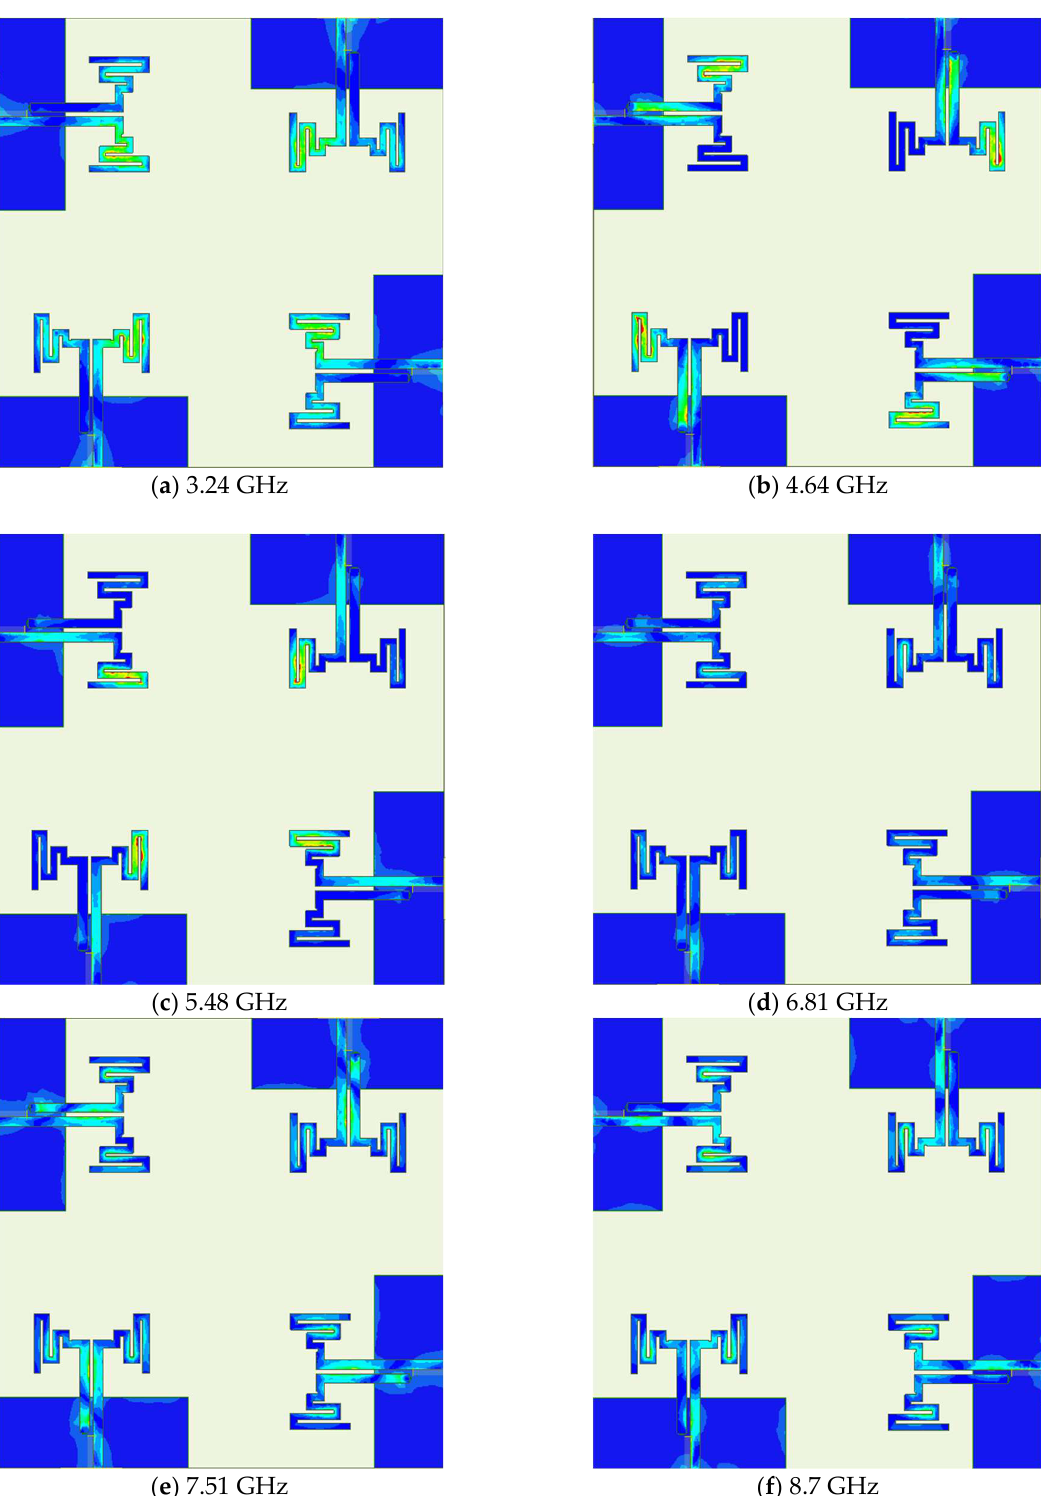
Figure 9. Four-element MIMO antenna configuration.